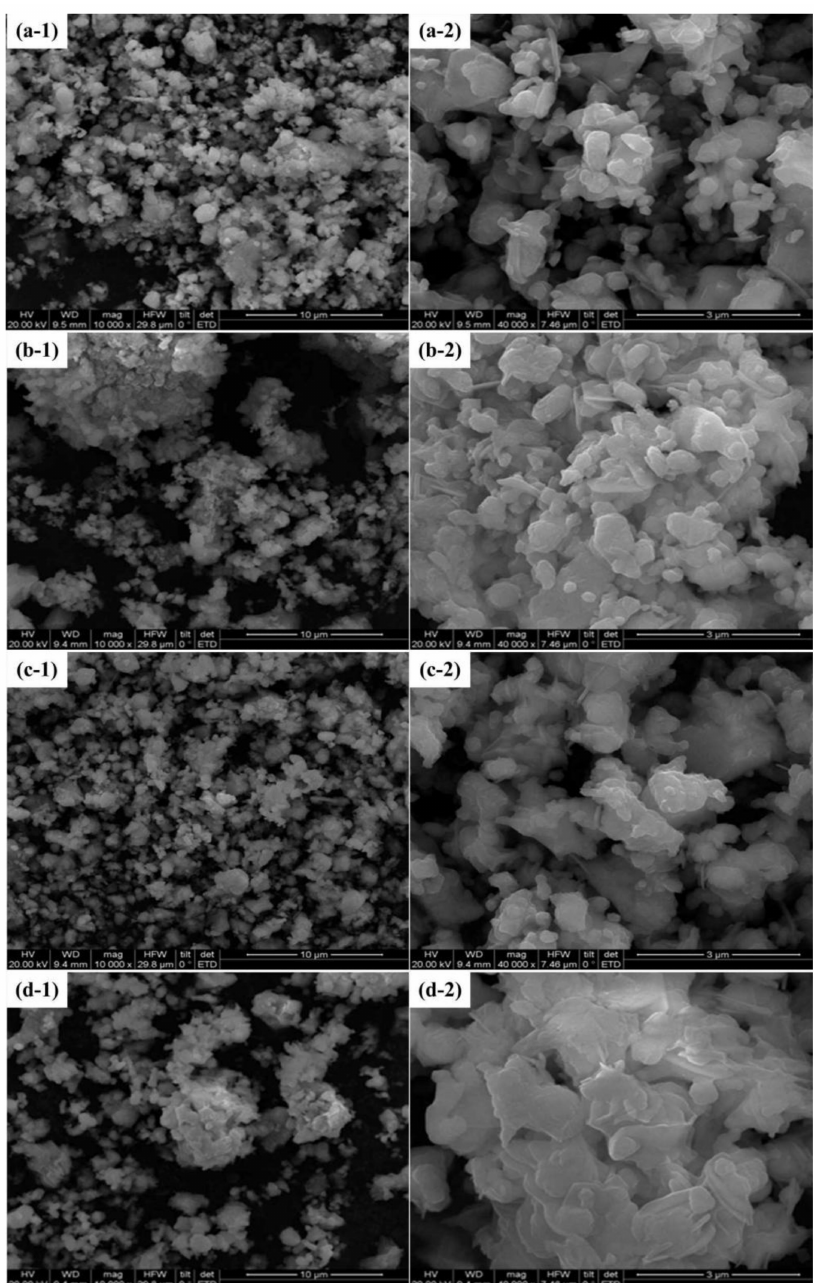
Figure 5. Microstructure of roasted products at different roasting times and temperatures: ( a-1 , a-2 ) and ( b-1 , b-2 ) denote the SEM images at a roasting temperature of 750 ◦ C, a roasting time of 120 min and 240 min, respectively; ( c-1 , c-2 ) and ( d-1 , d-2 ) denote the SEM images at a roasting time of 120 min, a roasting temperature 850 ◦ C and 950 ◦ C,